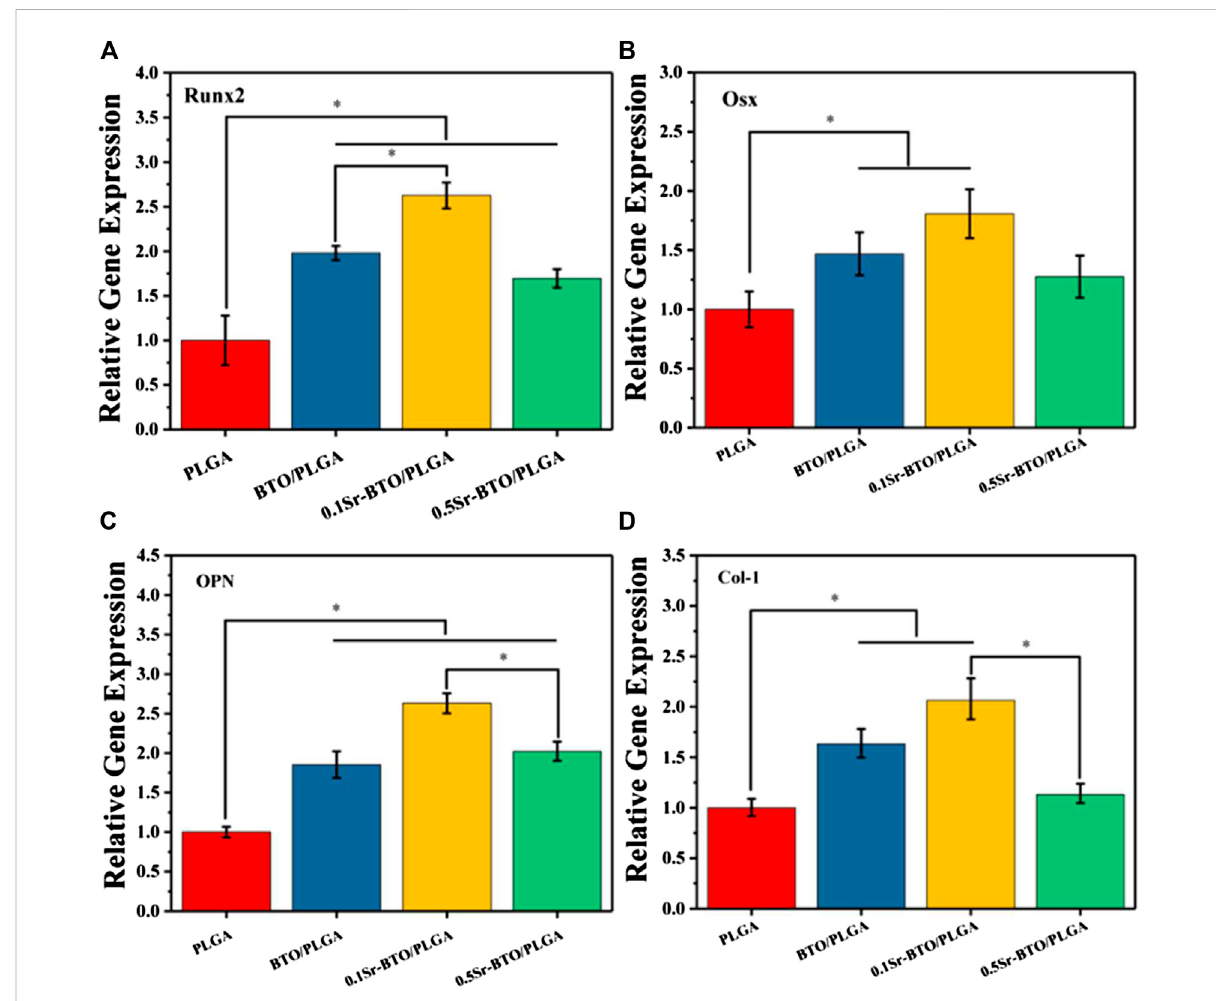
FIGURE 7 RT-PCR results of MC3T3-E1 cultured on different microspheres for 7 days: relative gene expression levels of (A) Runx 2, (B) Osx, (C) OPN, and (D) Col-1; GADPH was used as a reference gene. * p < 0.05.